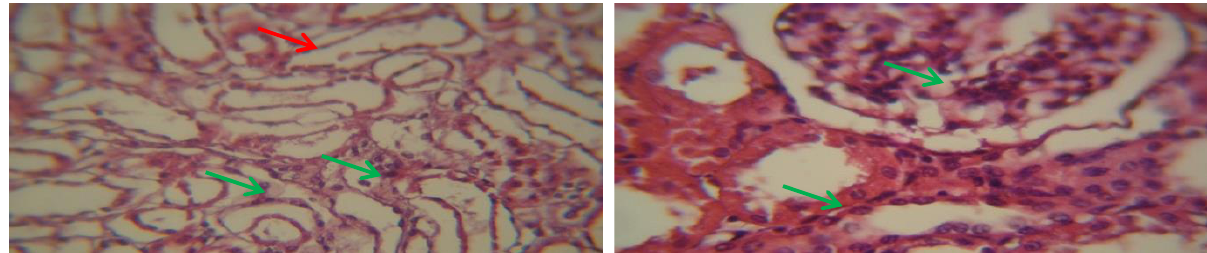
Figure 5. Section of kidney in GTZ group shows normal renal cortex with normal glomeruli (red arrow) and renal tubules (green arrow) and normal renal tubular epithelium in the medulla (green arrow). H&E 100× and 400×